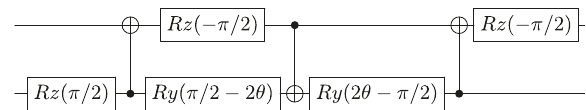
Fig. 8 Gate decomposition. Circuit to implement iRBS ( θ ) gate.